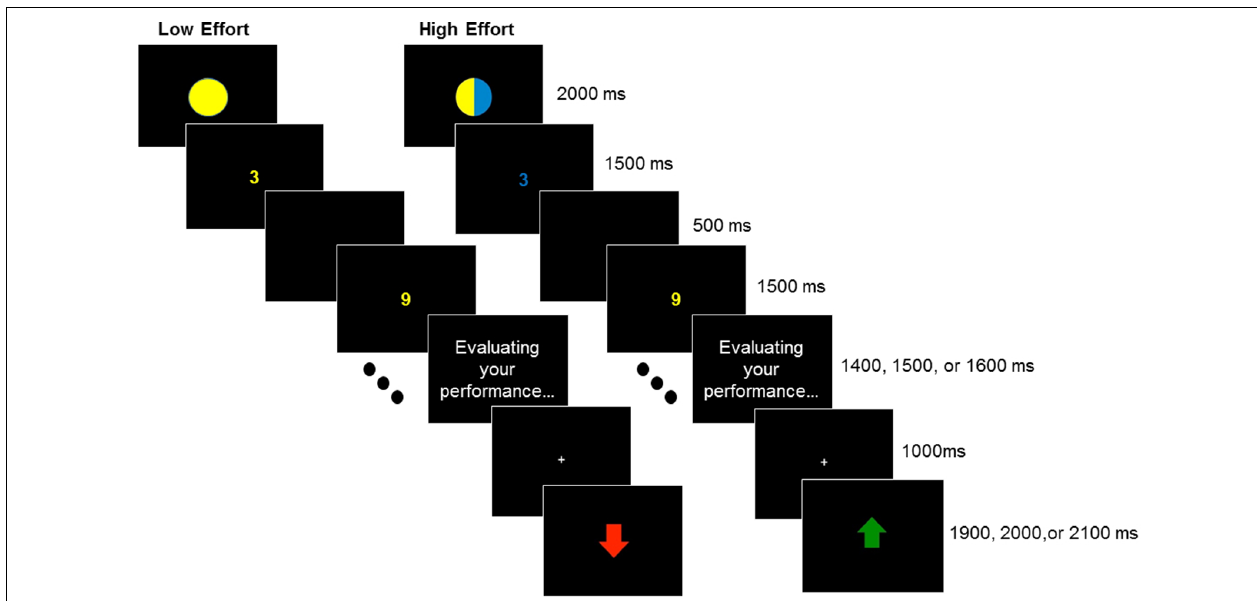
FIGURE 1 | Low1 effort (left) and high effort (right) blocks for the number judgment task. Each block included 10 numerals and ended with either reward or loss